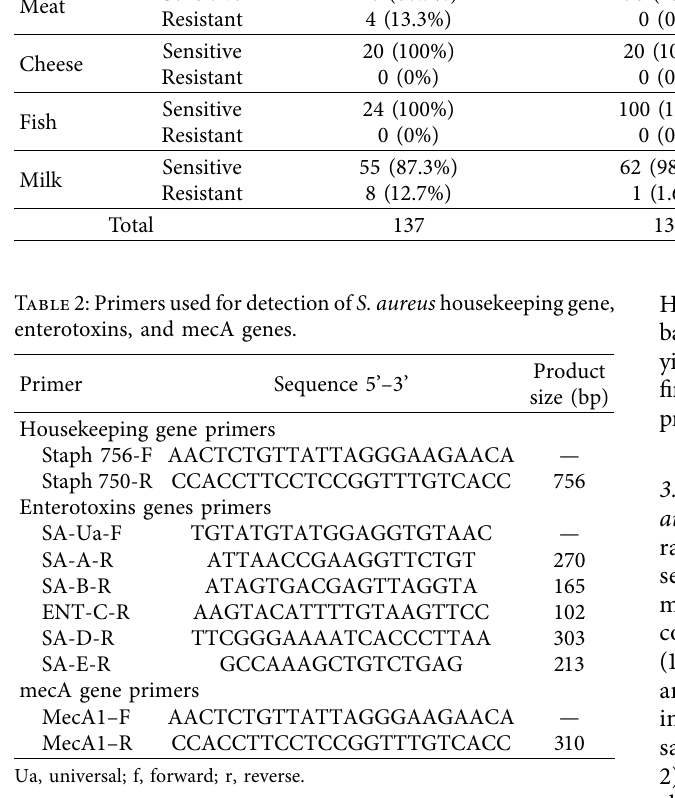
Table 1: Antimicrobial sensitivity pattern of Staphylococcus aureus isolated from different food material samples. Isolates